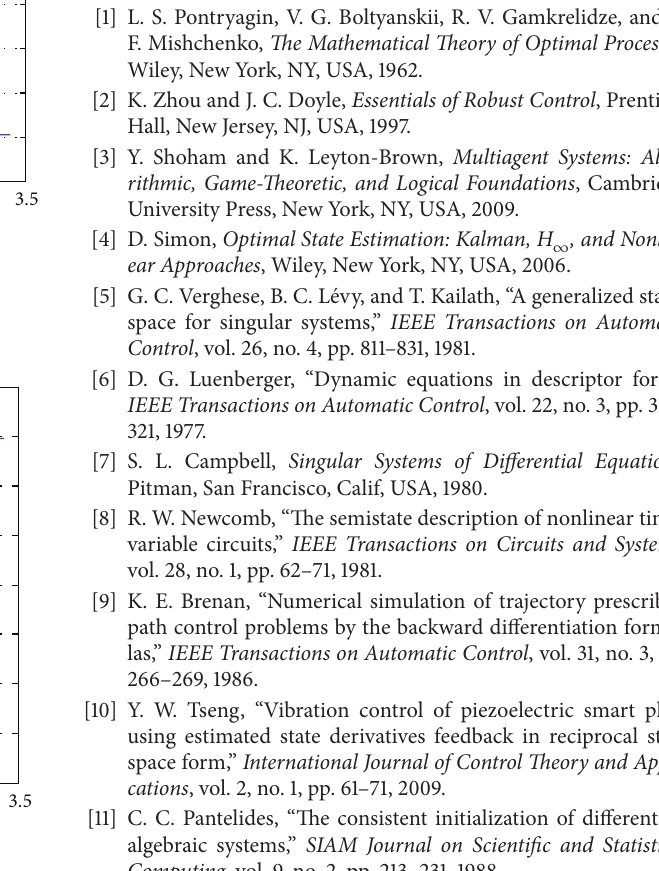
Figure 4: Trajectory of 𝜃 2